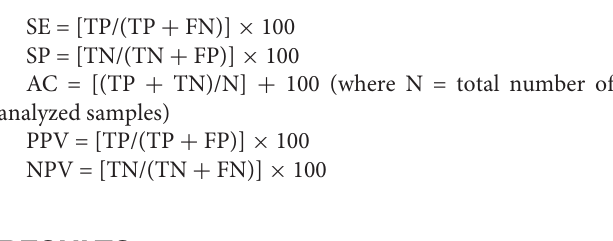
Frontiers in Microbiology |